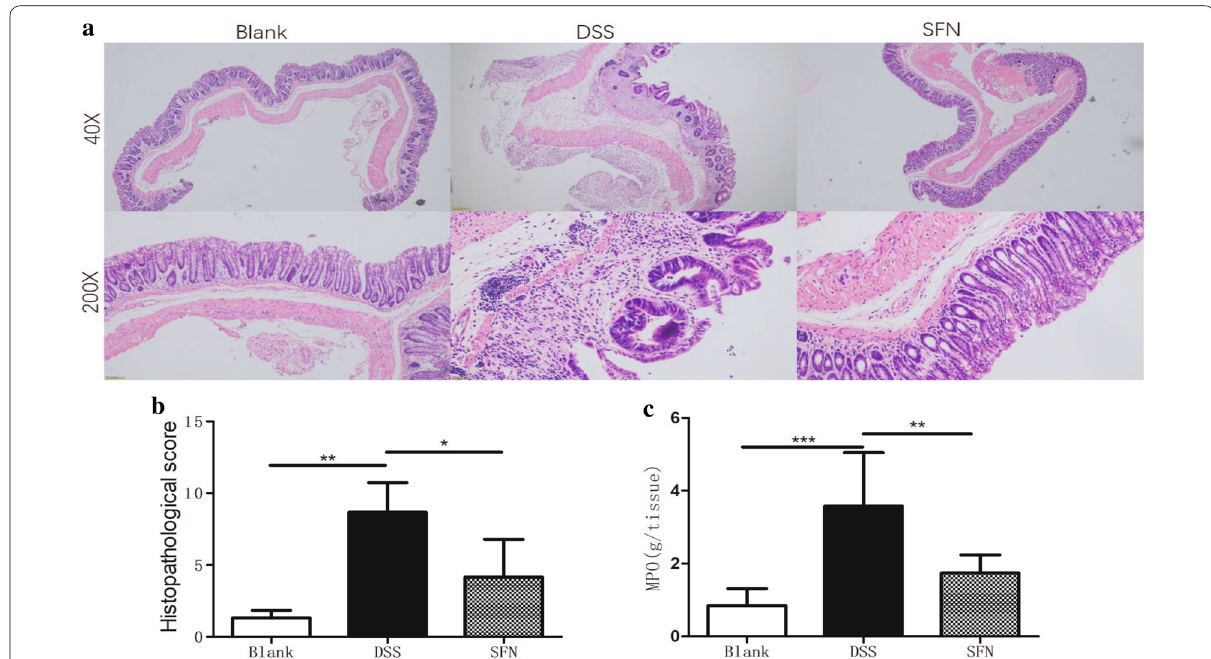
Fig. 2 Sulforaphane (SFN) pretreatment alleviated DSS-induced colon inflammation ( a ) Histopathological changes after DSS stimulation in colon ( 40, 200). b Effects of SFN on microscopic damage scores. c Effects of SFN on MPO activity. *P < 0.05, **P < 0.01, ***P < × ×